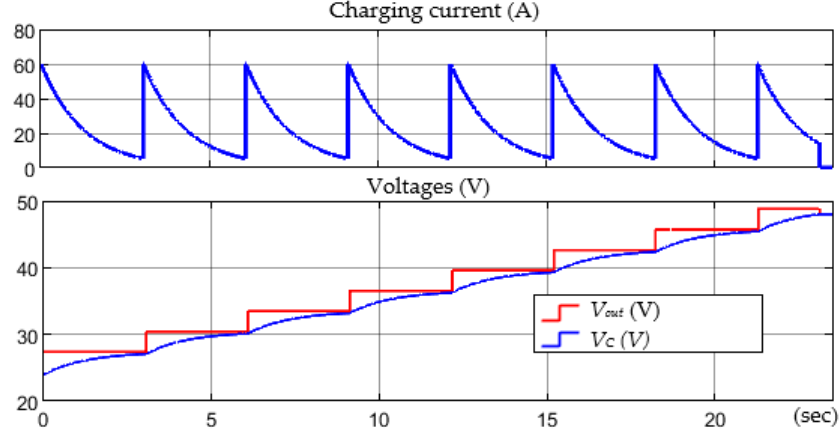
Figure 37. SC charging simulation result diagrams.